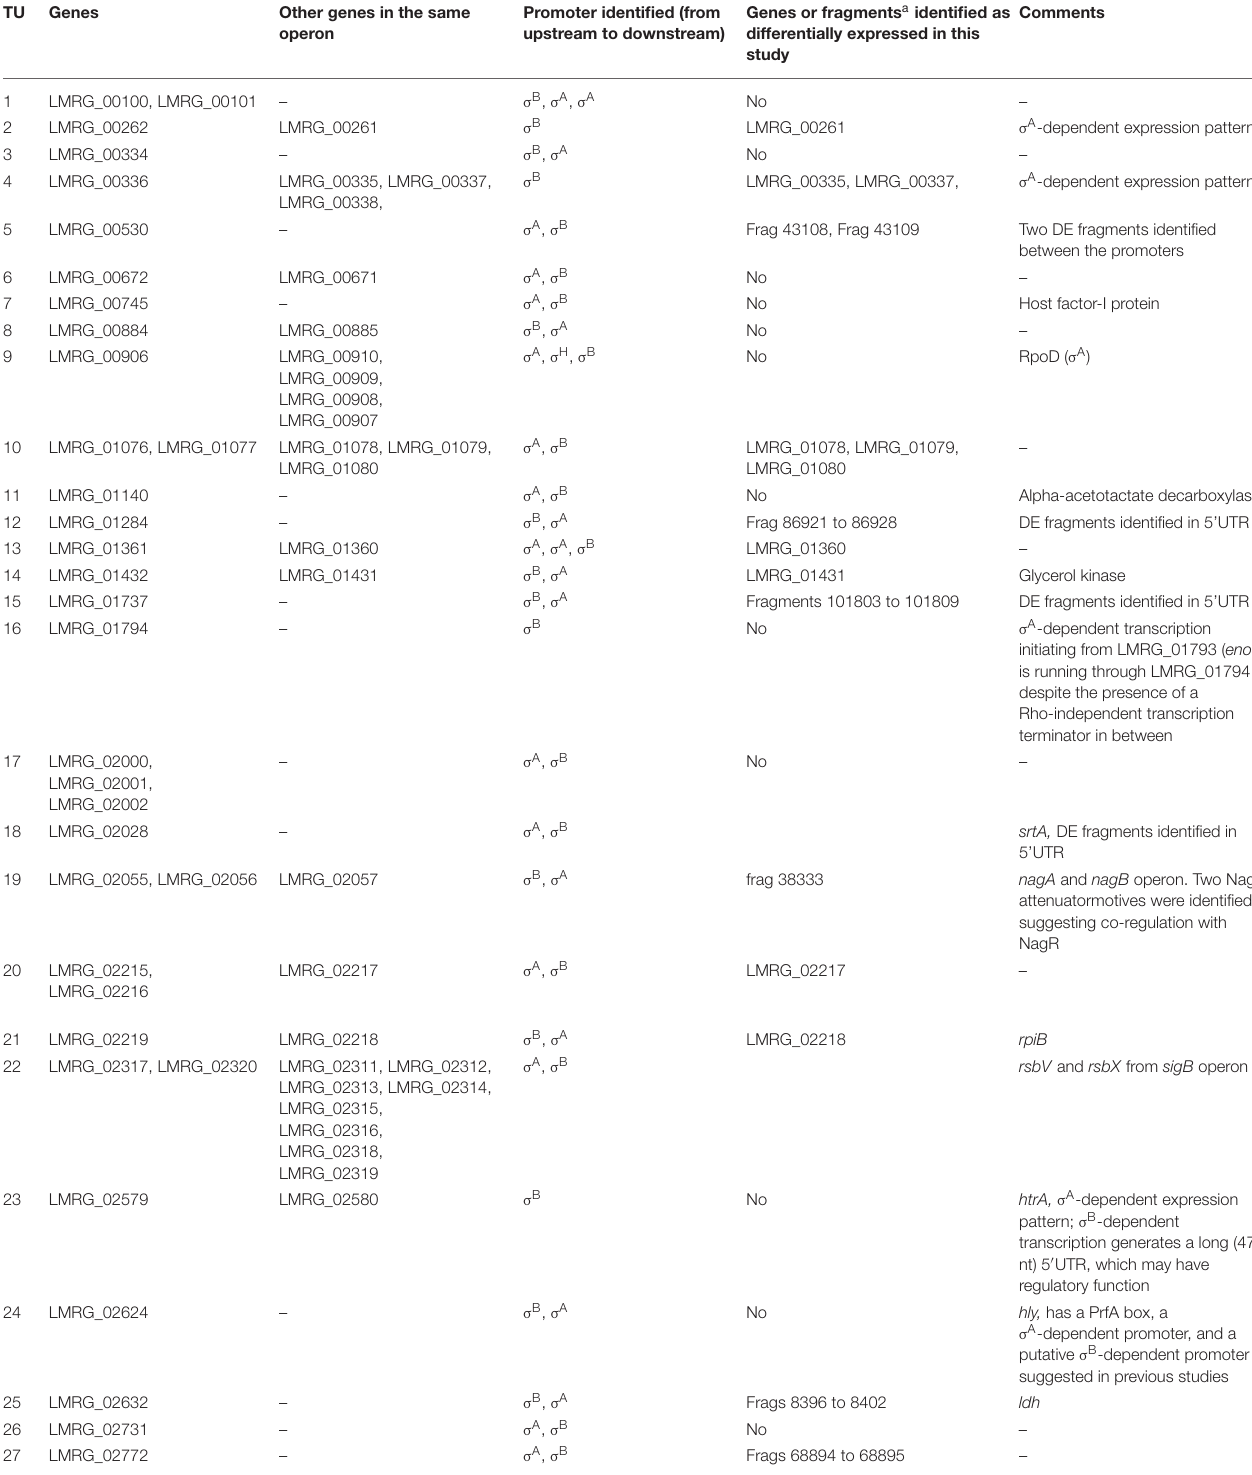
TABLE 5 | Co-regulation of σ A and σ B among the NDE σ B -dependent genes. TU Genes Other genes in the same